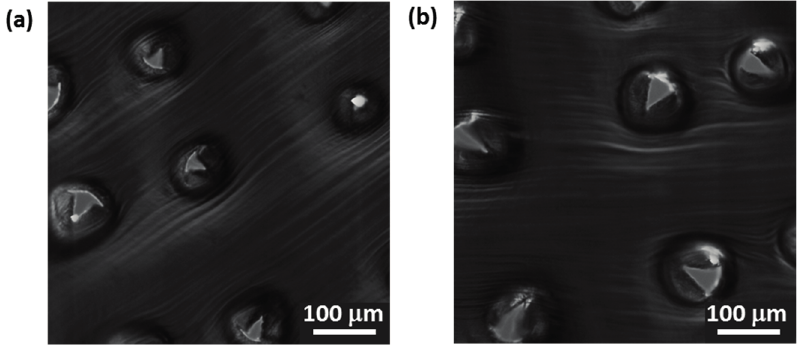
Figure 12. Optical micrograph analysis for G4-npMNA on PDMS as skin model. ( a ) Detailed image of G4-3×3-R200 puncture holes; ( b ) Detailed image of G4-3×3-R25 puncture holes. Scale bar = 100 µm.